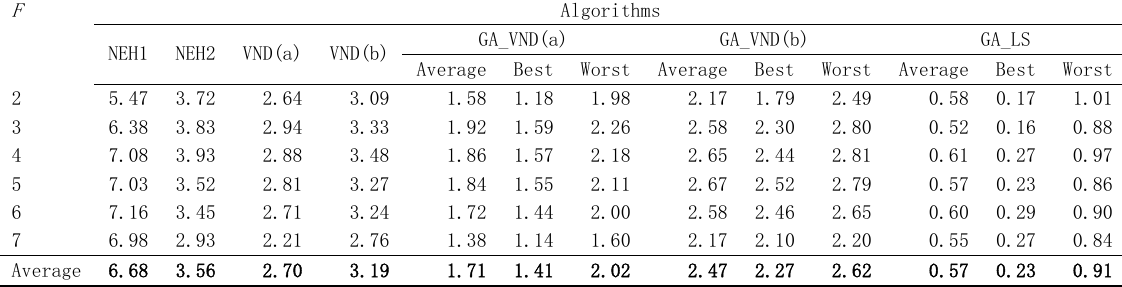
Table 2. Average relative percentage deviation ( RPD ) of algorithms grouped by F